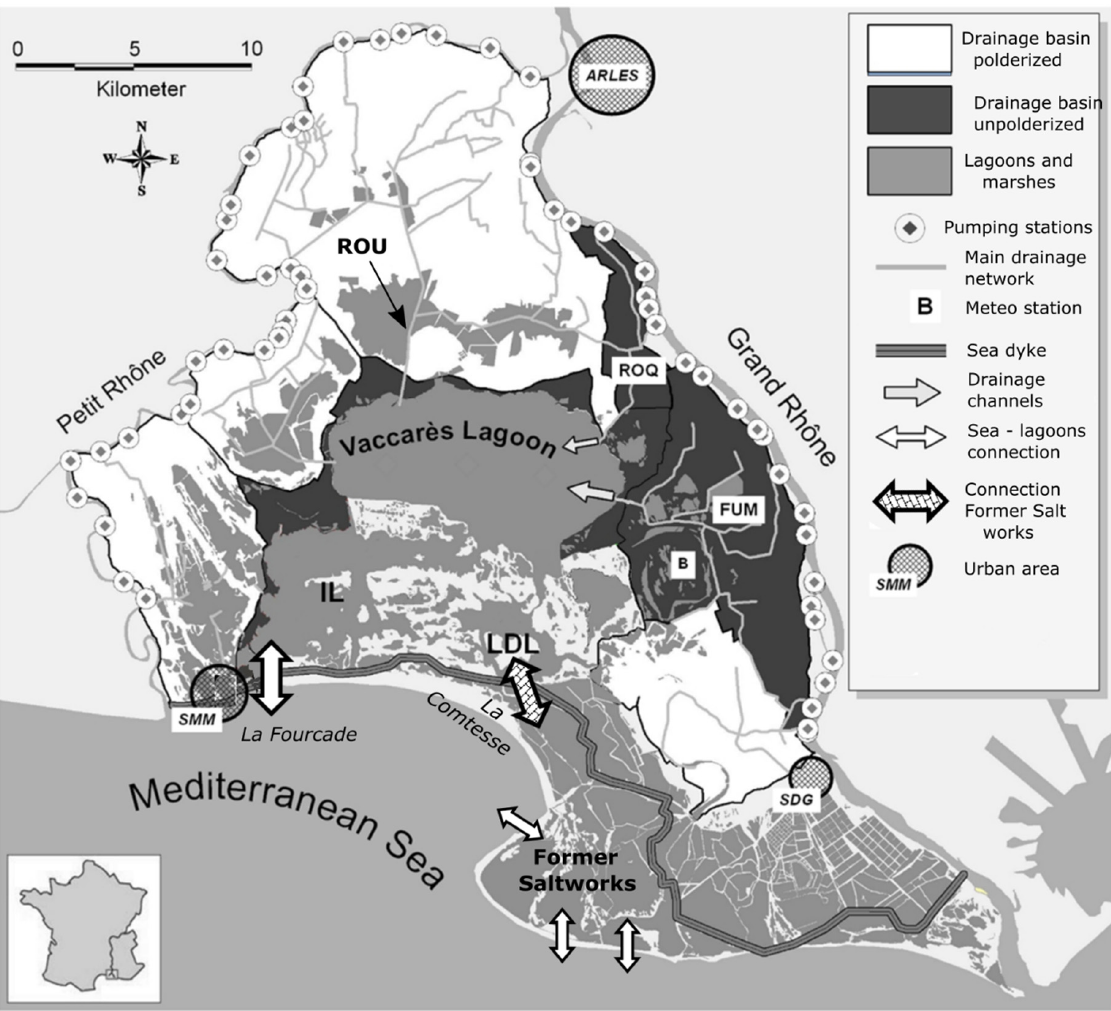
Figure 1. General Map of the Ile de Camargue basin delimited by the two arms of the Rhône river (Petit Rhône to the West, Grand Rhône to the East). SMM and SDG represent the coastal towns of Saintes-Maries de la Mer and Salin-de-Giraud, France. FUM, ROQ and ROU represent the Fumemorte, Roquemaure, and Rousty channels, respectively. Adapted from [23].